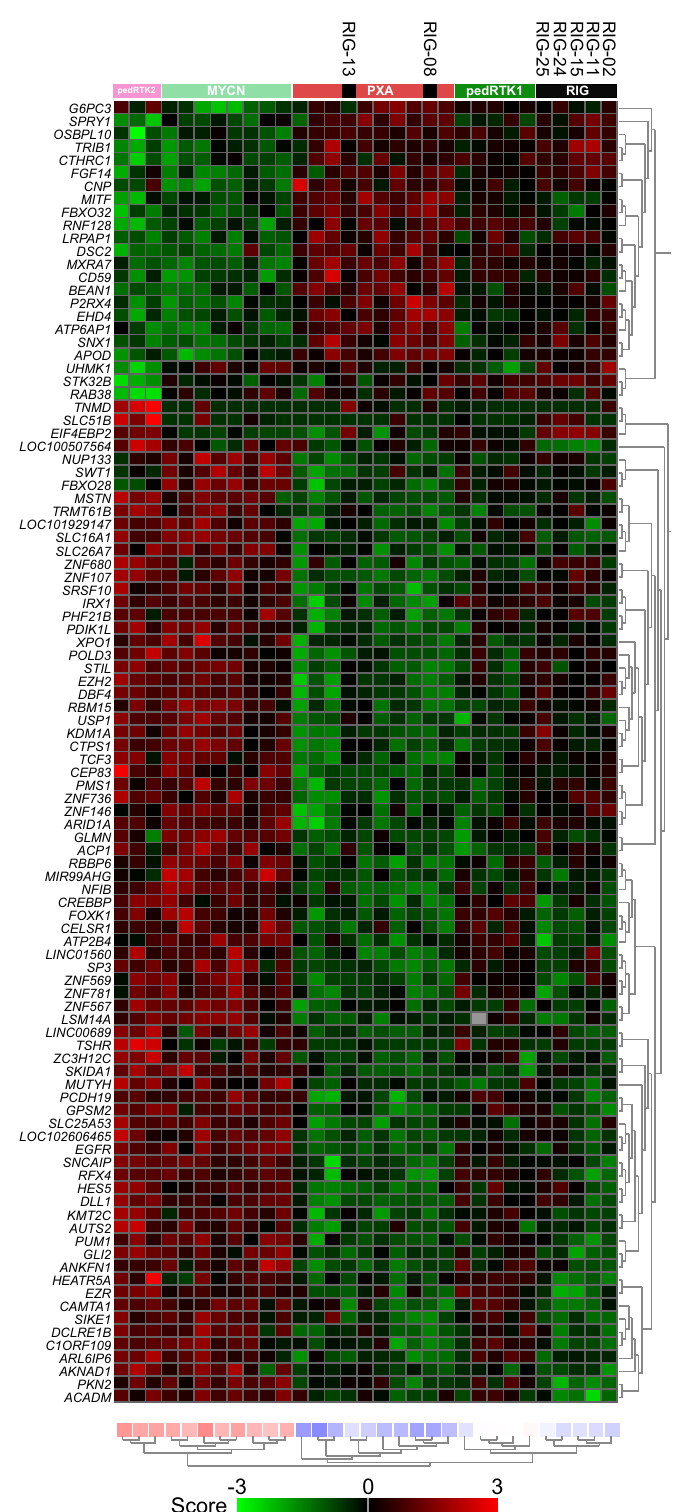
Fig. 7 Heatmap representing the expression levels of the 100 most signi fi cant, differentially expressed genes comparing RIG samples with reference groups (PXA, pedGBM_RTK1, pedGBM_RTK2, and pedGBM_MYCN). Unsupervised hierarchical clustering reveals that gene expression pro fi ling re fl ects our aforementioned fi ndings based on DNA methylation pro fi ling, with most RIGs resembling the pedGBM_RTK1 subgroup and a small subset more similar to PXAs. Each column represents one sample and each lane represents one gene. Expression levels are indicated by a color scale as indicated. PXA pleiomorphic xanthoastrocytoma, pedGBM_RTK1 pediatric glioblastoma subclass RTK1, pedGBM_RTK2 pediatric glioblastoma subclass RTK2, pedGBM_MYCN pediatric glioblastoma subclass